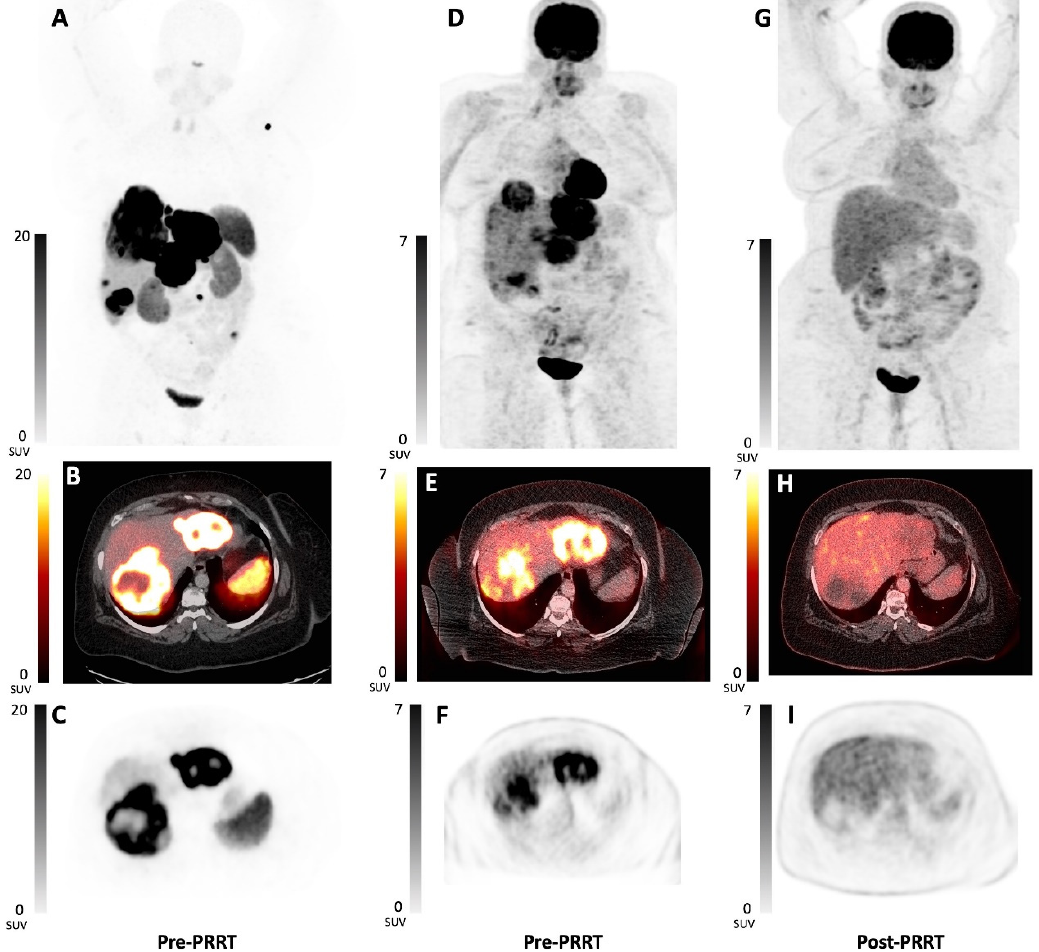
Figure 3. Example of FDG positive disease and response after 2 cycles PRRT. Thirty-two-year-old patient with an advanced neuroendocrine tumor of the small intestine (Ki-67 index: 10%) that presented with disease progression after previous treatment with somatostatin analogues, everolimus and temozolomide-capecitabine. She was deemed eligible for peptide receptor radionuclide therapy (PRRT) after work-up. 68 Ga-DOTATATE PET/CT scan prior to PRRT (( A ) maximum intensity projection (MIP) image; ( B ) fusion PET/CT; ( C ) native PET) showed strongly increased somatostatin receptor-expression in the malignant bone, lymph nodes and liver metastases. 18 F-FDG PET/CT prior to PRRT (( D ) MIP image; ( E ) fusion PET/CT; ( F ) native PET) showed strong 18 F-FDG-avidity in the liver metastases. 18 F-FDG PET/CT after 2 cycles of PRRT revealed a complete metabolic response in the liver metastases (( G ) MIP image; ( H ) fusion PET/CT; ( I ) native PET). SUV = standardized uptake